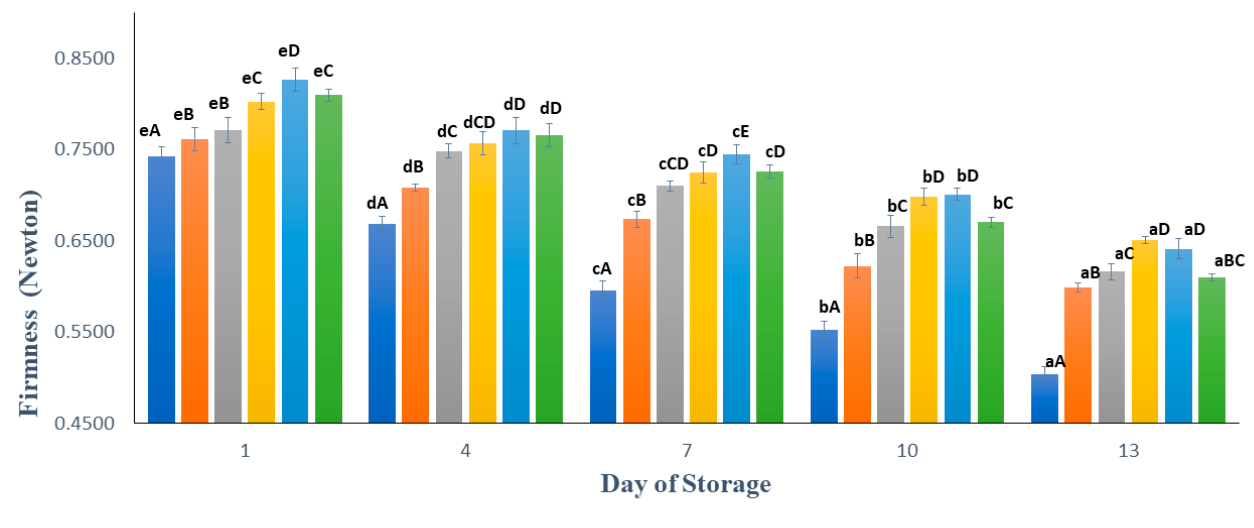
Figure 3. Effect of edible coating of gelatin composite enriched with black tea extract on the hardness (Newton) of minimally processed watermelon during storage. The value shown is the average of the three experimental replications. A–E Values followed by the same capital letters showed no significant difference ( p > 0.05) between treatments on the same day. a–e Values followed by the same non-capital letters showed no significant difference ( p > 0.05) between storage times in the same treatment.